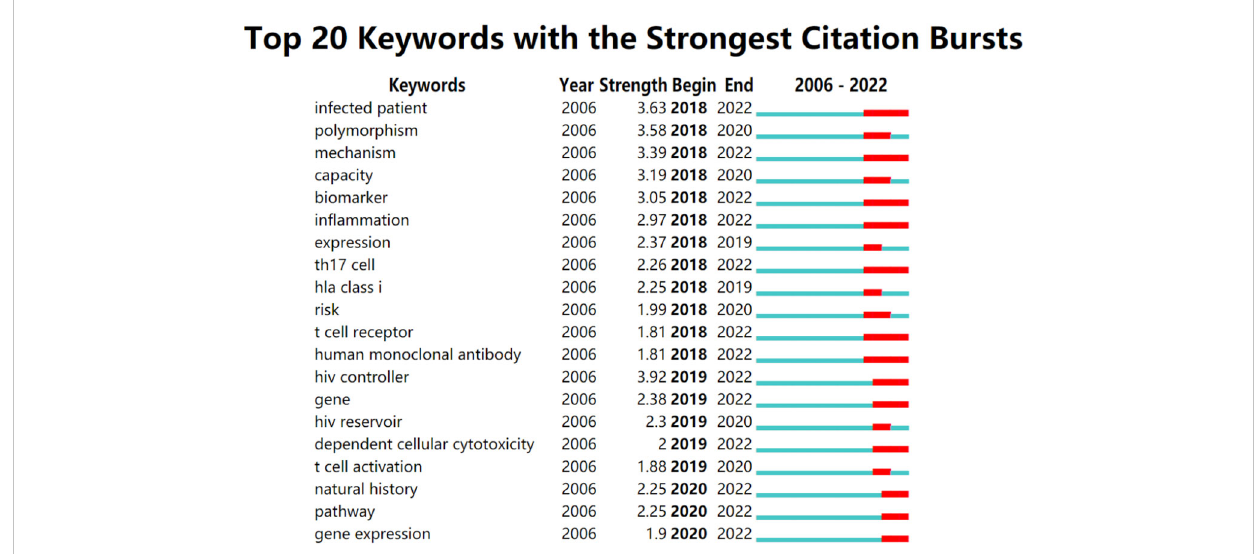
FIGURE 8 Top 20 keywords with the strongest burst values in the last 5 years on elite controller research. The red line corresponds to the period of surge in